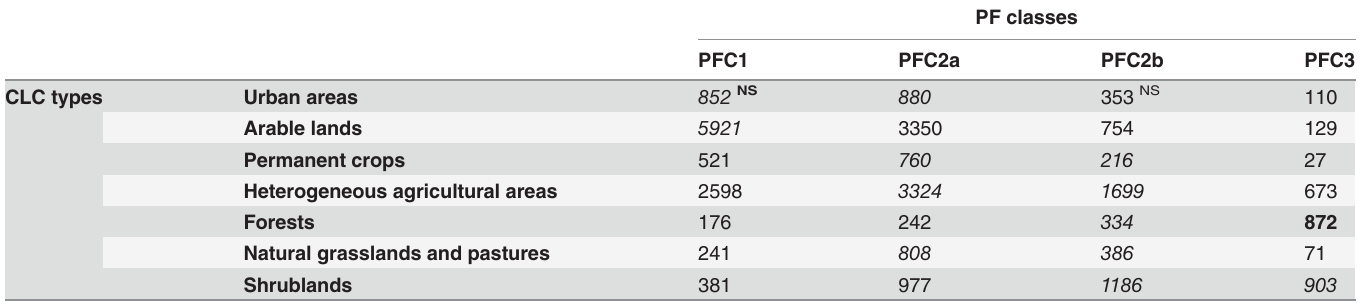
Table 2. Contingency table showing the number of fi res shared by the phenological fuel classes (PFCs) and the Corine Land Cover (CLC) types during the period 2000 – 2010.